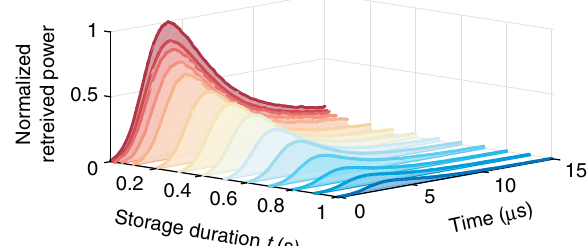
Fig. 5 1 s long light storage. Light storage for up to t = 1 s of short ( τ p = 5.5 μ s) signal